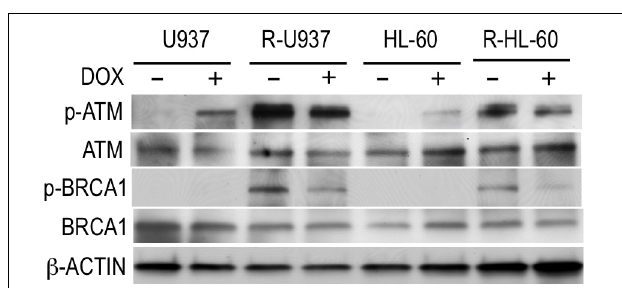
FIGURE 4 | The profile of phosphorylation of ATM and BRCA1 in shHP1 γ -infected cells after incubation with (+) or without (–) 1 µ g/ml doxycycline for 72 h were shown. The typical result from three-times repeated experiments was